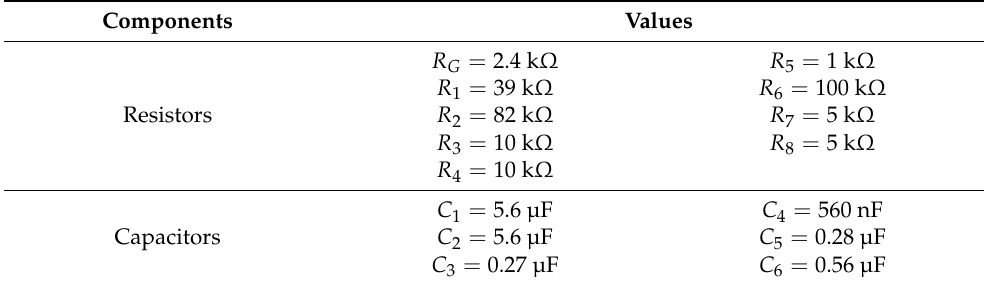
Table 1. Components values of the first signal conditioning circuit.